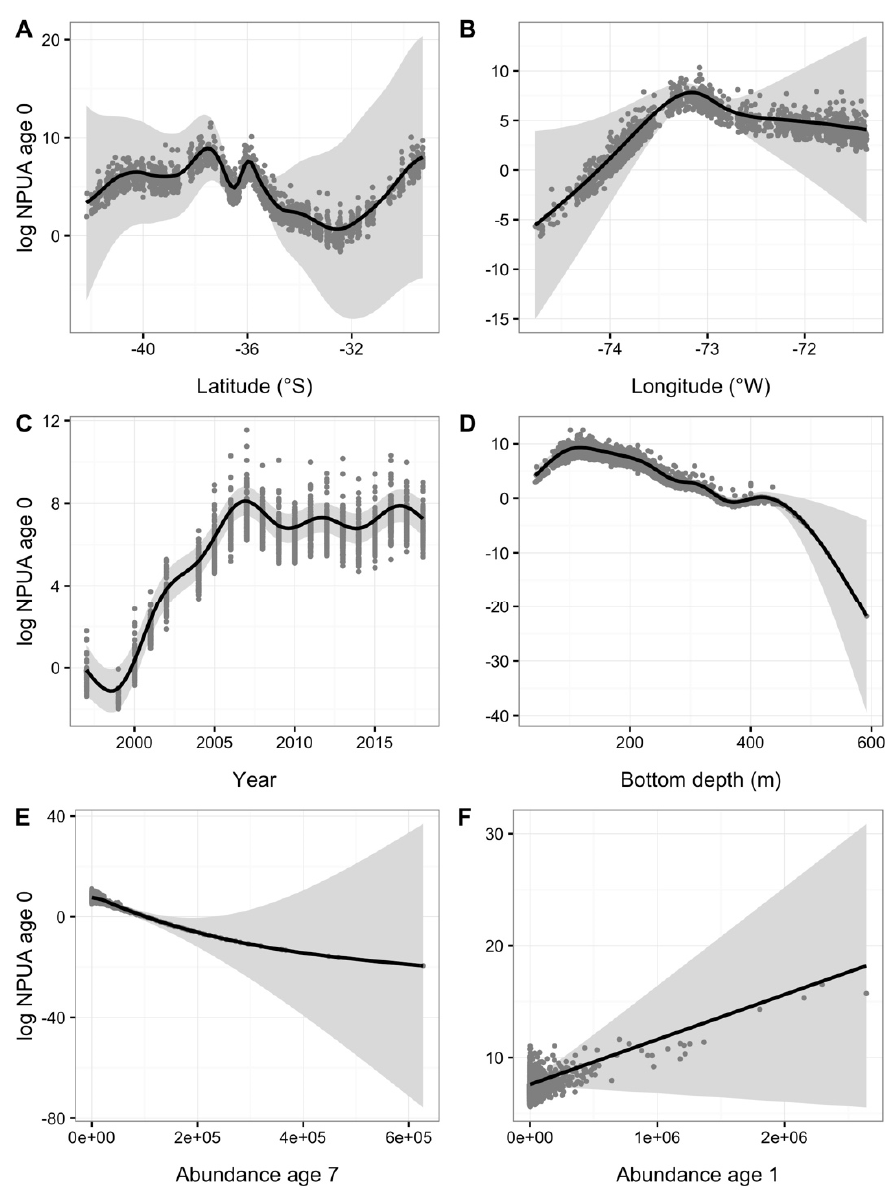
Figure 6. Relationships between the abundance of juvenile Chilean hake of age 0 and relevant variables for spatiotemporal effects latitude ( A ), longitude ( B ), year ( C ), bottom depth ( D ) and endogenous effects of older adult hake of age 7+ ( E ) and juvenile hake of age-1 ( F ), according to the best model fitted (Model M0.7, Table 2).